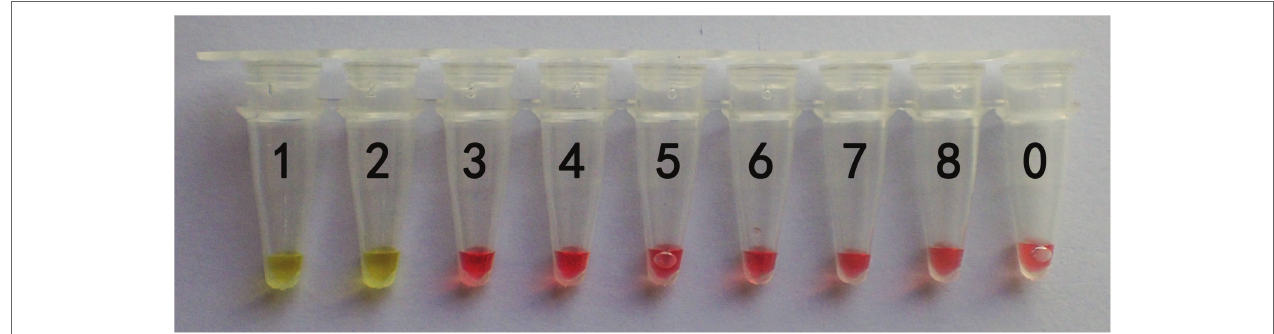
FIGURE 5 | Sensitivity results of the LAMP primers set I of Gyromitra infula. The minimum DNA concentration detected was evaluated by using a series of Gyromitra infula DNA dilutions. 1: 10 ng/ μ l; 2: 1 ng/ μ l; 3: 0.1 ng/ μ l; 4: 0.01 ng/ μ l; 5: 1 pg/ μ l; 6: 0.1 pg/ μ l; 7: 0.01 pg/ μ ; 8: 1 fg/ μ l; 0: ddH 2 O. The color changing to yellow indicated a positive reaction.